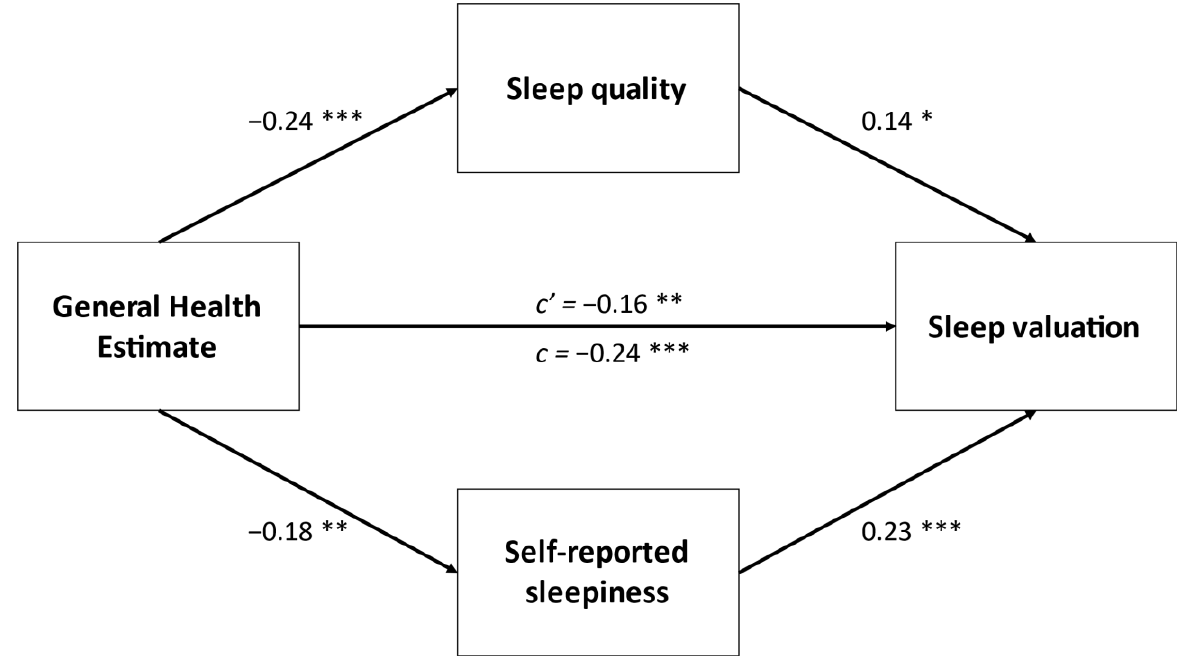
Figure 2. Parallel mediation between self-reported general health estimate and sleep valuation. Values are standardized β . * p < 0.05, ** p < 0.01, *** p < 0.001.